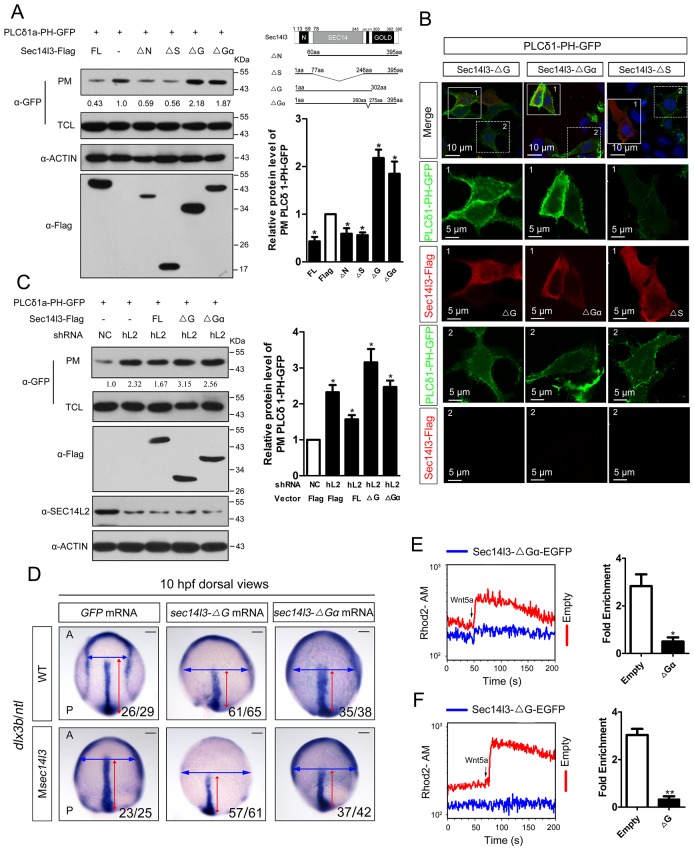
Sec14l3 activates PLC dependent on its GOLD and Gα domains.(A) Analysis of PIP2 levels in the membrane. Different forms of Sec14l3 (right corner) were co-transfected with PLCδ1-PH-GFP into HEK293T cells, and PIP2-bound PLCδ1-PH-GFP in the PM was detected by Western blot. The relative levels of PLCδ1-PH-GFP in the PM were quantified and presented as mean ± SEM from three independent experiments on the right (*p<0.05). (B) Immunofluorescence of PLCδ1-PH-GFP (green, PIP2 probe) in HEK293T transfected with Sec14l3-ΔG, Sec14l3-ΔGα or Sec14l3-ΔS (red) respectively. Regions in white box are enlarged. Scale bar, 10 μm for the first panel and 5 μm for the enlarged panels. (C) PIP2 accumulation in stable SEC14L2-knockdown cells was not abolished by overexpression of Sec14l3-ΔG or Sec14l3-ΔGα. Statistical data from three independent experiments are presented as mean ± SEM on the right (*p<0.05). (D) CE defects in embryos with ΔG and ΔGα Sec14l3 overexpression. dlx3b/ntl marker gene expression were examined at 10 hpf after sec14l3-ΔG and sec14l3-ΔGα mRNA injection respectively. Scale bar, 100 μm. (E–F) Flow cytometry of Wnt5a-induced calcium signals in PC3 cells transfected with Sec14l3-ΔGα or Sec14l3-ΔG (blue curves). Left panel shows the kinetic calcium influx over a time course. Right panel shows fold enrichment of calcium influx after Wnt5a stimulation. Data from three independent experiments are presented as mean ± SEM (*p<0.05, **p<0.01). Blue and red curves indicate the transfected and control group respectively. All numerical data represented as a graph in the figure are shown in Figure 4—source data 1.DOI:
http://dx.doi.org/10.7554/eLife.26362.01510.7554/eLife.26362.016Figure 4—source data 1.Numerical data for relative protein level of PLCδ1-PH-GFP or phosphorylation level ratio in Figure 4 and Figure 4—figure supplement 1.